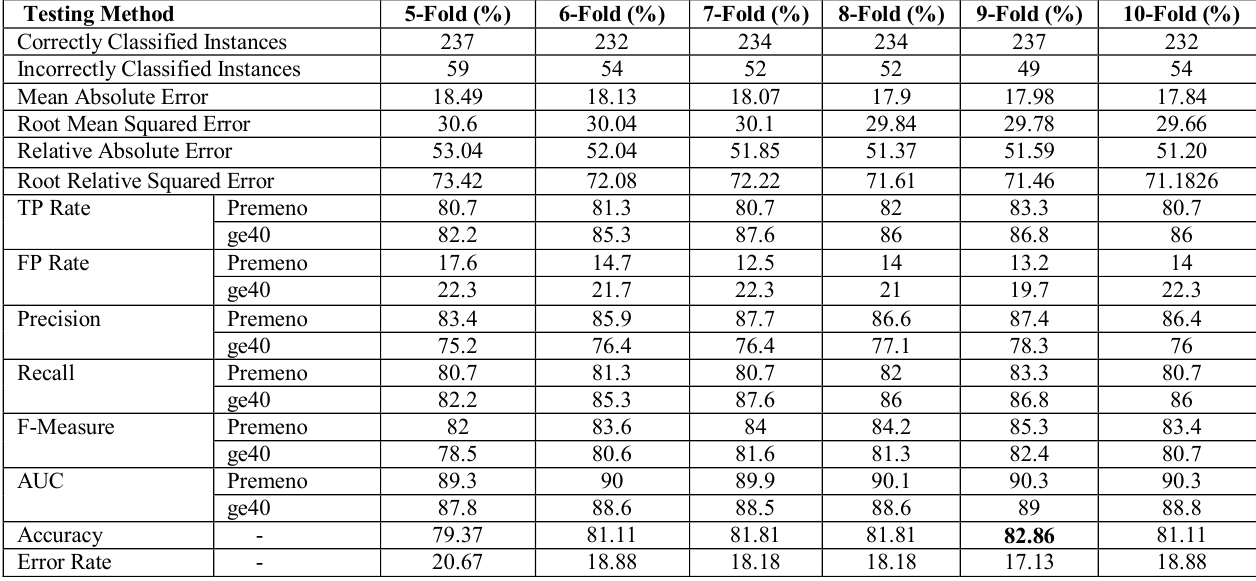
Table 5. Performance metrics of Naïve Bayes using method